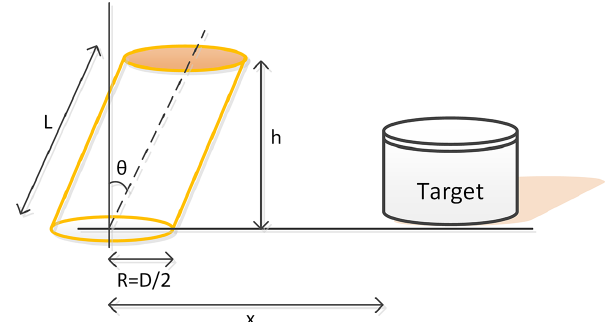
Figure B1. Flame as a tilted